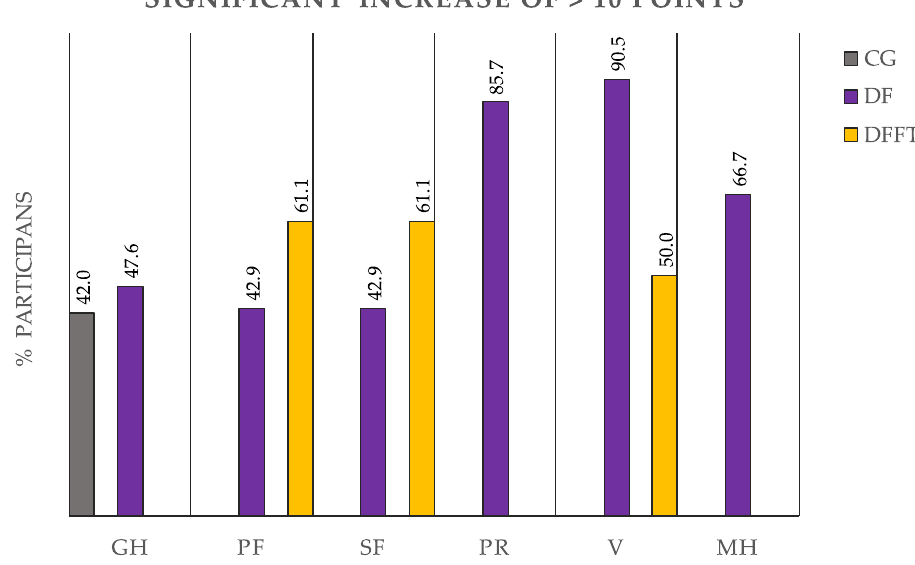
Figure 3. Percentage of participants with a significant score improvements of more than 10 points compared with the baseline. General Health (GH), Physical Functioning (PF), Social Functioning (SF), Physical Role (PR), Vitality (V), and Mental Health (MH). DF group = Dance Fitness group; DFFT = Dance Fitness and functional strength training group.